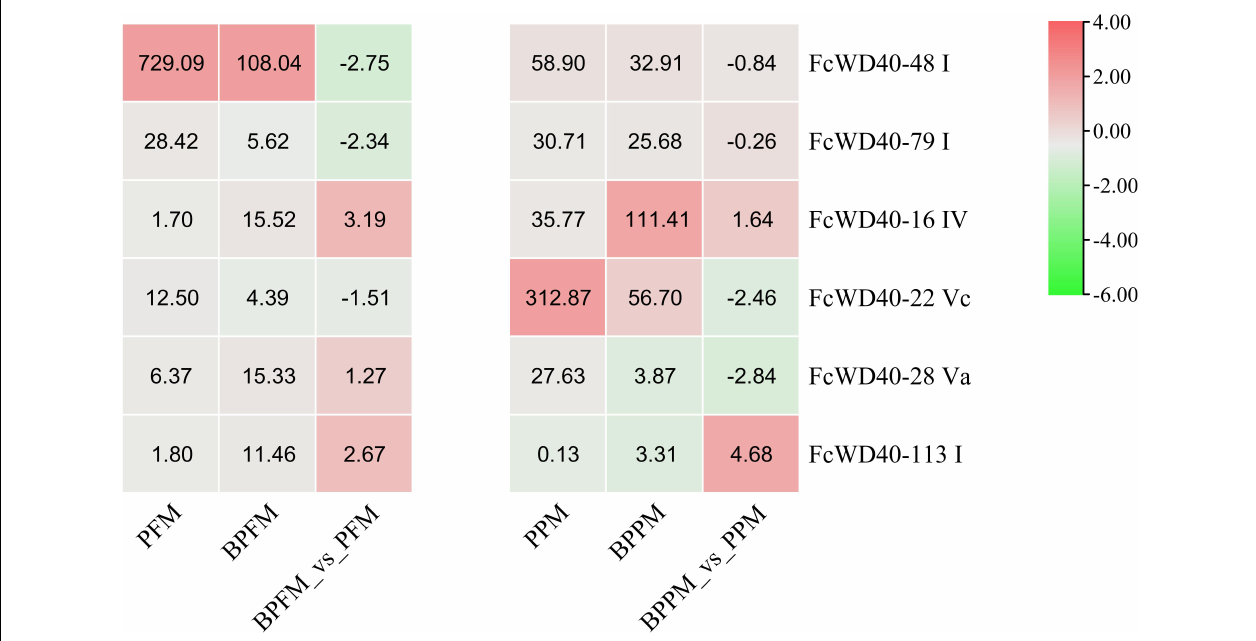
FIGURE 4 | Expression profiles of FcWD40 genes under light deprivation. PFM and PPM represent the mature-stage flesh and peel of “Purple-Peel,” respectively; BPFM and BPPM represent the bagging mature-stage flesh and peel of ‘Purple-Peel’ fruit,